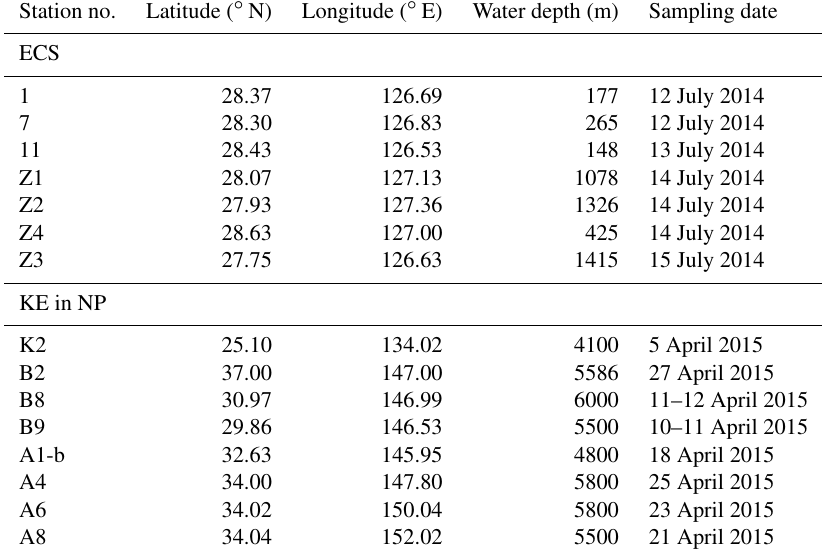
Table 1. Summary of sampling stations and times in the ECS and the KE in the northwestern North Pacific (NP). Station no.